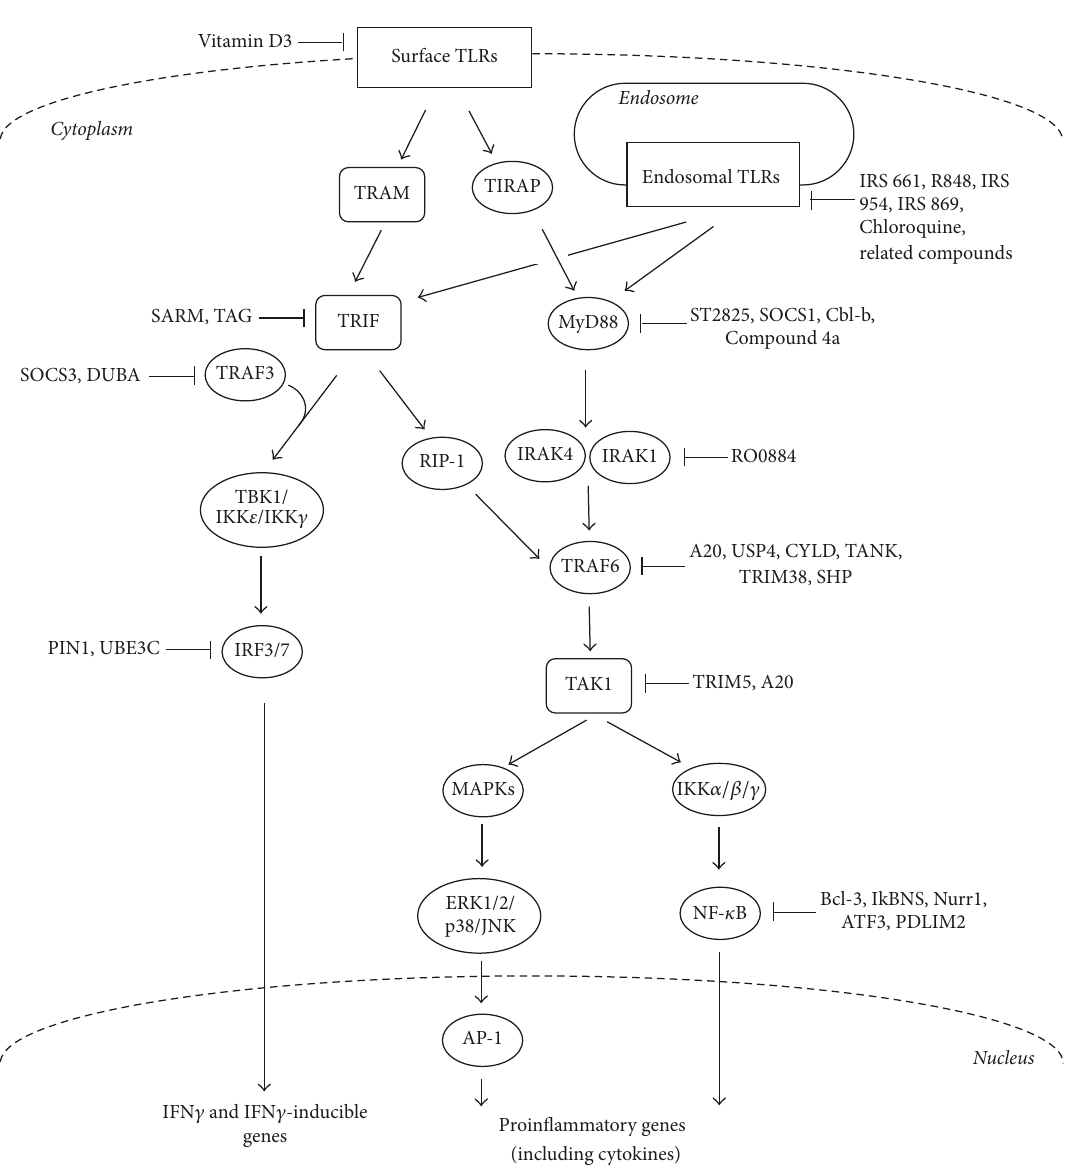
Figure 2: TLR signalling inhibitors. The regulation of TLR signalling has been achieved through the application of both natural and synthetic inhibitory molecules, which target each of the key molecules in the TLR signalling pathways, acting through a wide range of mechanisms. (AP-1, activator protein 1; ATF, activating transcription factor; ERK, extracellular signal-regulated kinase; IKK, inhibitor of kappa light polypeptide gene enhancer in B-cell kinase; IRAK, IL-1 receptor-associated kinase; JNK, c-Jun N-terminal kinase; MKK, MAPK kinase; RIP1, receptor interacting protein 1; TAB, transforming growth factor-b-activated kinase 1/MAP3K7-binding protein; TAK, transforming growth factor-activated kinase; TRAF, tumour necrosis factor receptor-associated factor); A20, Tumour Necrosis Factor Inducible Protein A20; ATF3, Activating Transcription Factor 3; Bcl-3, B-Cell Lymphoma 3-Encoded Protein; Cbl-b, E3 Ubiquitin Protein Ligase Cbl-b; CYLD, Ubiquitin-Specific-Processing Protease CYLD; DUBA, Deubiquitinating Enzyme A; HA900, high molecular weight hyaluronan; IkBNS, NF- 𝜅 B Inhibitor Delta; Nurr1, Nuclear Receptor Related 1; PDLIM2, PDZ and LIM Domain Protein 2; PIN1, Peptidylprolyl Cis/Trans Isomerase, NIMA-Interacting 1; SARM, Sterile Alpha and TIR Motif Containing 1; SHP, Small Heterodimer Partner; SOCS1, Suppressor of Cytokine Signalling 1; SOCS3, Suppressor of Cytokine Signalling 3; TAG, splice variant of the adaptor TRAM; TANK, TRAF Family Member Associated NF- 𝜅 B Activator; TRIM5, Tripartite Motif Containing 5; TRIM38, Tripartite Motif Containing Protein 38; UBE3C, Ubiquitin Protein Ligase E3C; USP4, Ubiquitin Specific Peptidase